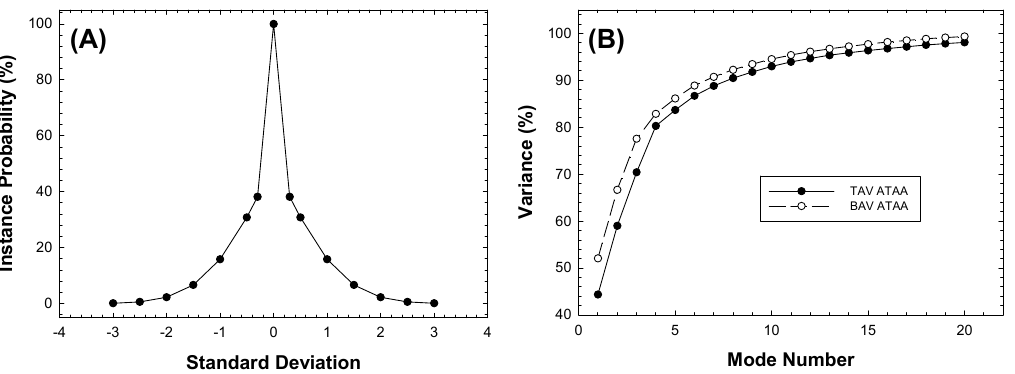
Figure 1. ( A ) Shape probability curve as a function of standard deviation; ( B ) scree plot of PCA-related shape modes for BAV ATAA and TAV ATAA.